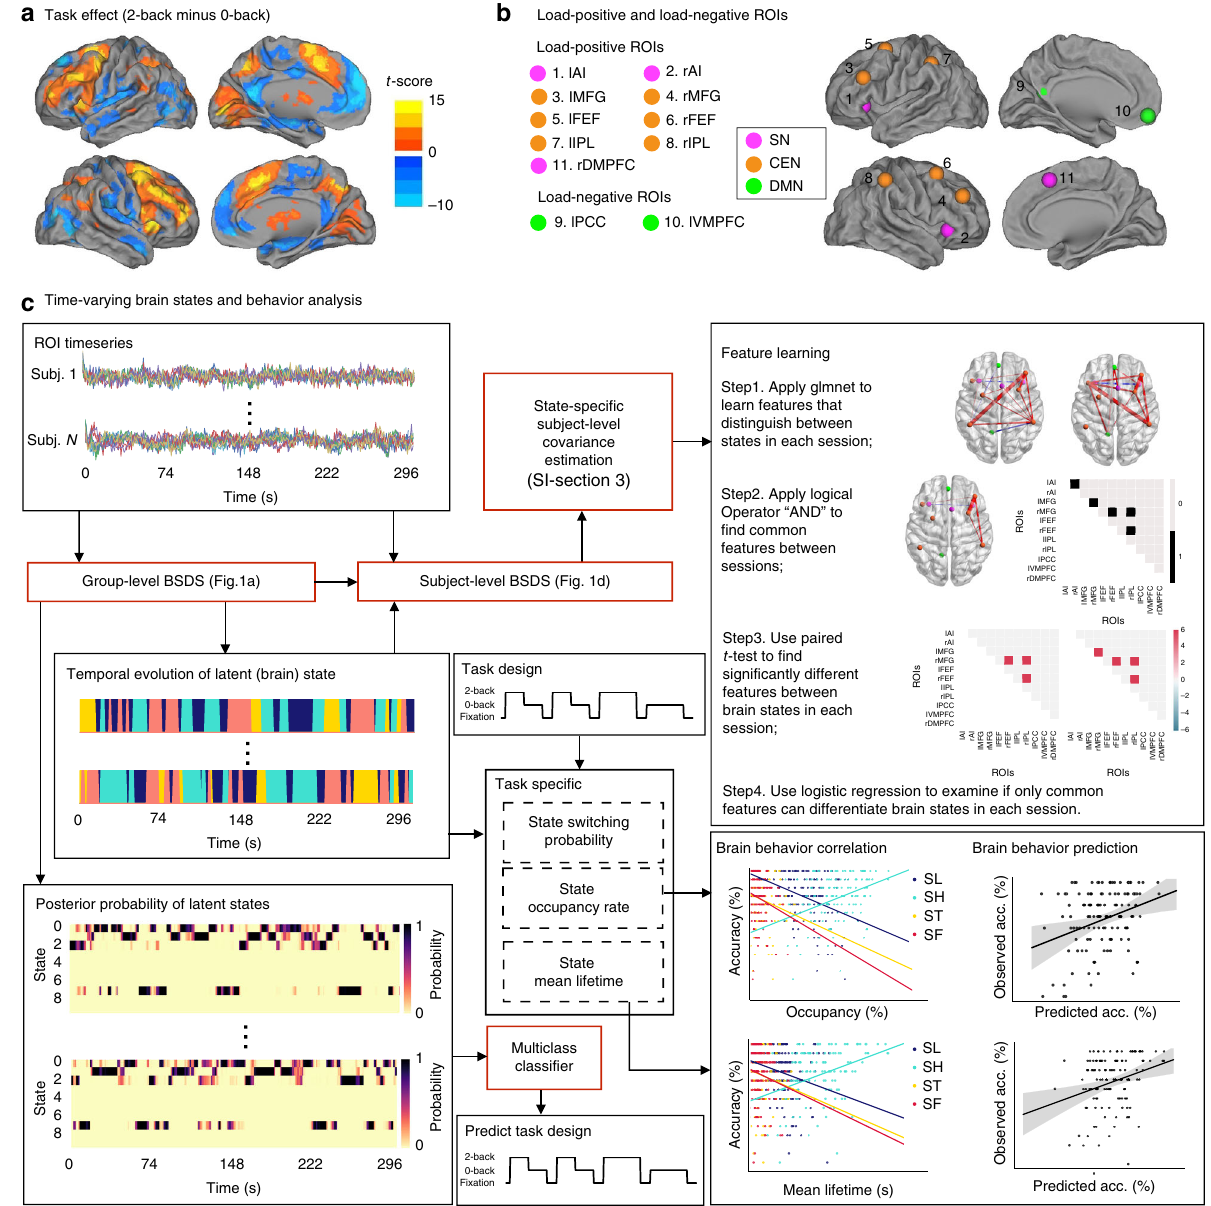
Fig. 3 Application of BSDS to human WM data from the Human Connectome Project. a Brain regions activated (warm colors) and deactivated (cool colors) during the 2-back, compared to the 0-back, task condition. b Regions of interest (ROIs) were determined using activation and deactivation peaks from a . ROIs activated during WM predominantly overlapped with the Salience Network (SN) and Central Executive Network (CEN): 1, left anterior insula (lAI); 2, right anterior insula (rAI); 3, left middle frontal gyrus (lMFG); 4, right middle frontal gyrus (rMFG); 5, left frontal eye fi eld (lFEF); 6, right frontal eye fi eld (rFEF); 7, left intraparietal lobule (lIPL); 8, right intraparietal lobule (rIPL); and 11, right dosomedial prefrontal cortex (rDMPFC). ROIs deactivated during WM mainly overlapped with the Default Mode Network (DMN): 9, left posterior cingulate cortex (lPCC) and 10, left ventromedial prefrontal cortex